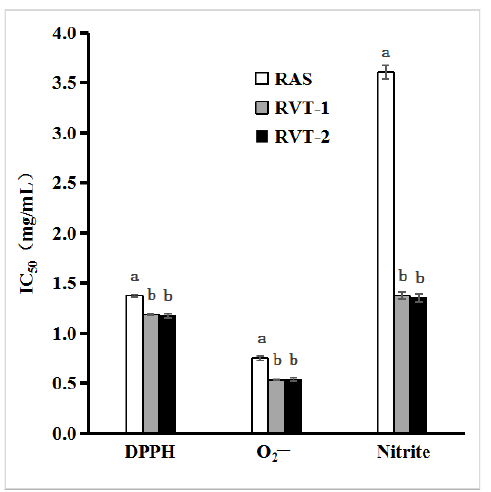
Figure 2. IC 50 values of DPPH, O 2 − radicals, and Nitrite inhibition for RVT and RAS. Values with different letters within the same substance are significantly different ( p < 0.05). All data were ex- pressed as the means ± SD, n = 3.